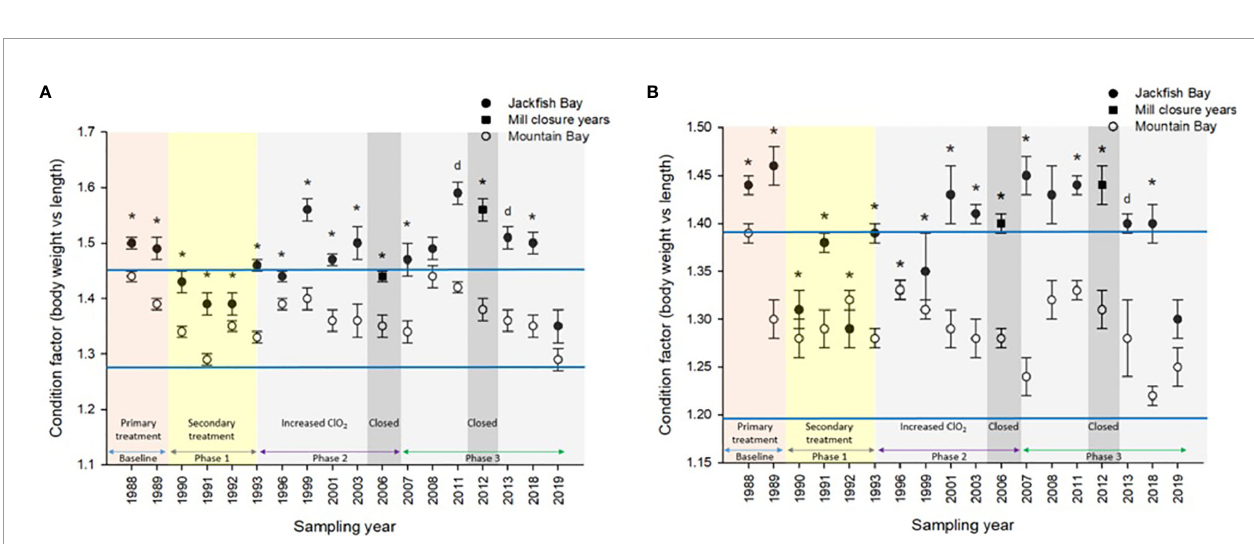
FIGURE 3 | Condition (± SE) of (A) female and (B) male white sucker ( Catostomus commersoni ) from Jack fi sh Bay and Mountain Bay, pre-spawning (spring) from 1988 to 2019. Asterisks* represent a signi fi cant difference (p ≤ 0.05) between sites within years, “ d ” represents an interaction between sites, horizontal blue bars represent the 30 year normal range for the reference site. All data before 2008 published in Bowron et al.